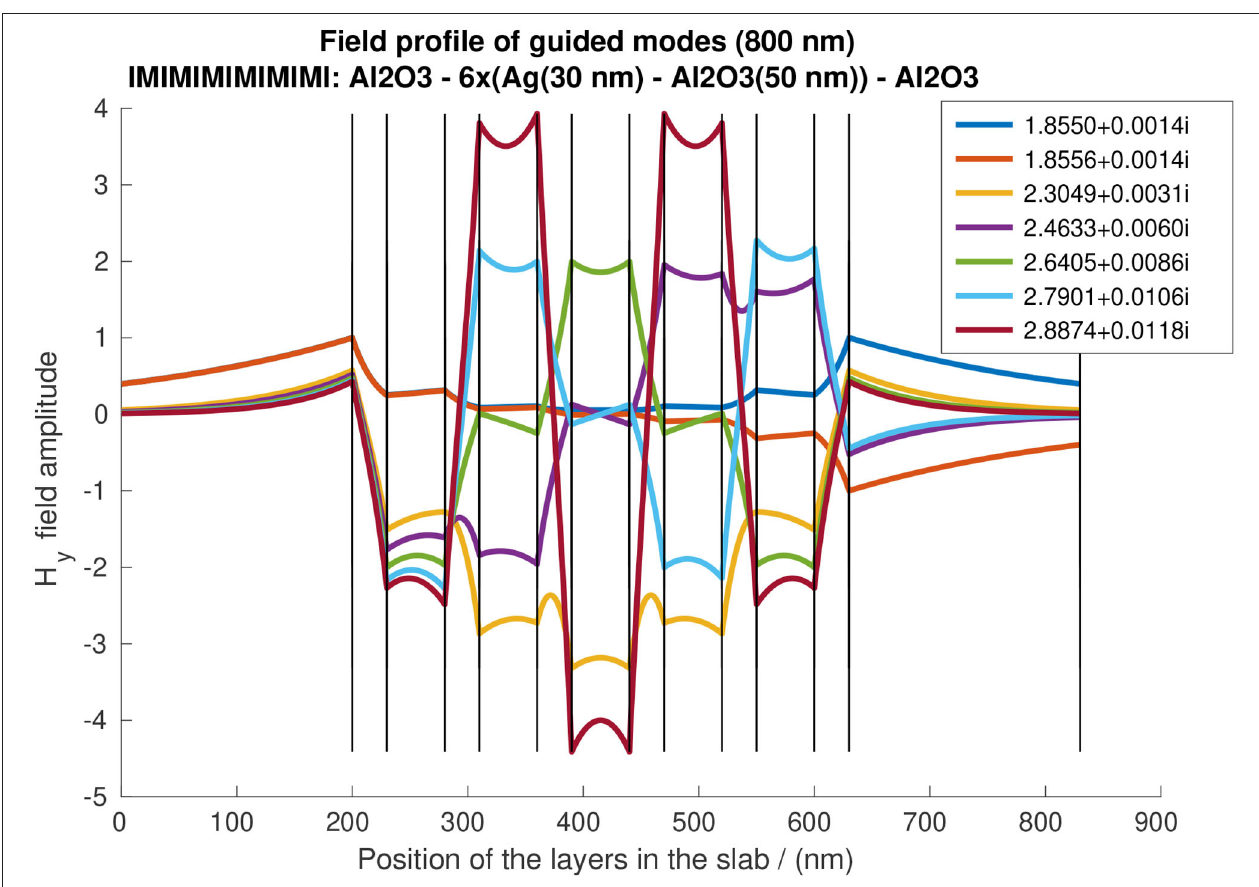
FIGURE 8 | Profiles of the field component H y for λ 800 nm along the stack of 6 silver layers of 30 nm thickness, separated by aluminum oxide layers of 50 nm = thickness. The vertical black lines indicate the boundaries between layers. The symmetry center is in the central dielectric layer.